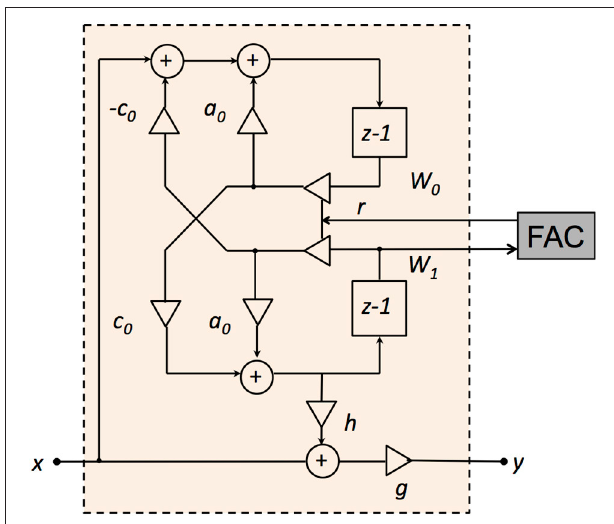
FIGURE 3 | Structure of the two-pole-two-zero resonator. a 0 , c 0, and h are the resonator coefficients, r is the pole/zero radius in the z plane, g is the DC gain factor, W 0 and W 1 are the intermediate variables, x is the input, and y is the output.